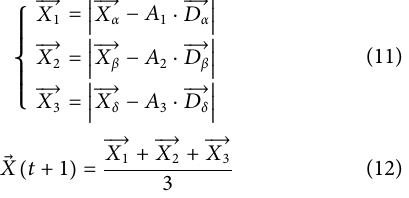
Equation 6 de fi nes the step length and the direction of ω individuals in the wolves towards α , β , and δ , and Eq. 7 de fi nes the fi nal position of ω .